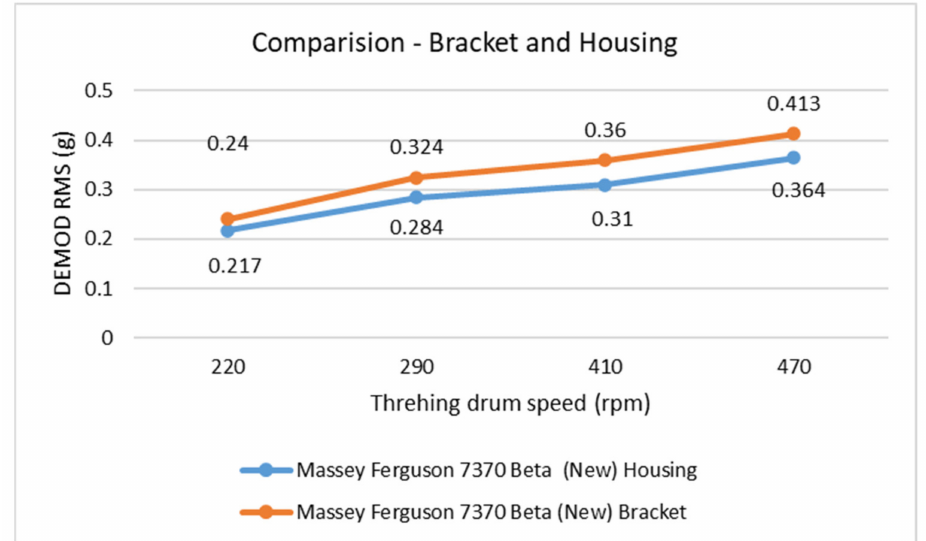
Figure 8. Comparison of the demodulated RMS value when the sensor is mounted on a bracket with respect to the housing of the Beta version in different threshing rotating speeds.